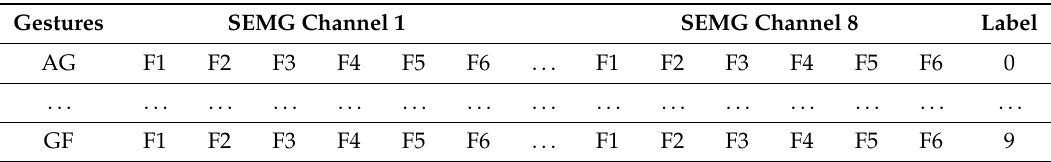
Table 1. The format of features extracted.